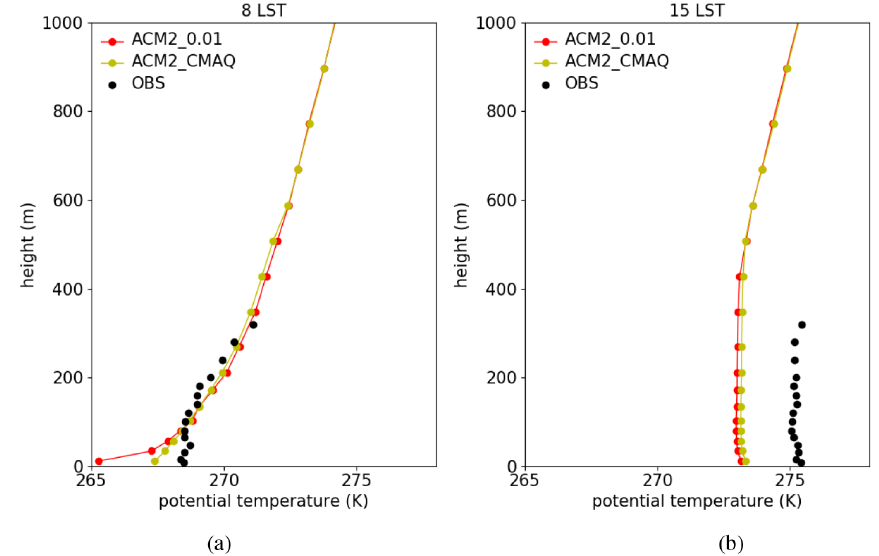
Figure 9. The vertical profiles of the potential temperature predicted by ACM2_0.01, and ACM2_CMAQ, and the observations at (a) 08:00LST and (b) 15:00LST averaged over the simulated days.